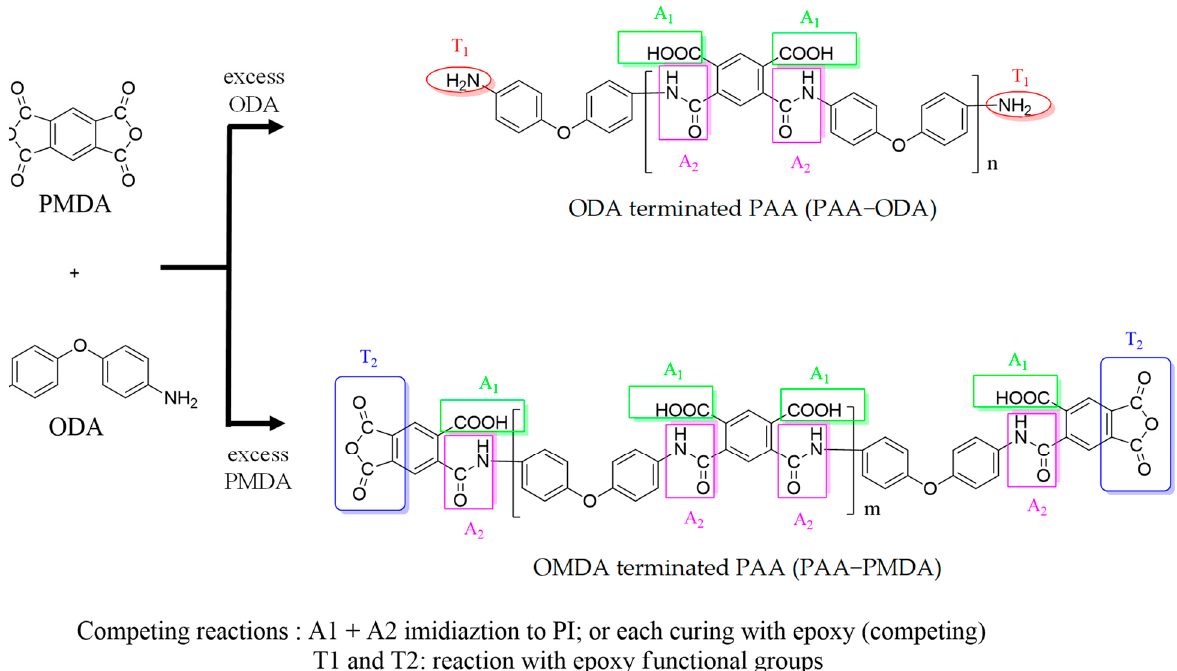
Figure 1. Reactive function groups of ODA terminated PAA (PAA-ODA) and PMDA terminated PAA (PAA-PMDA): amines (T1), anhydrides (T2), carboxylic acids (A1) and amides (A2).